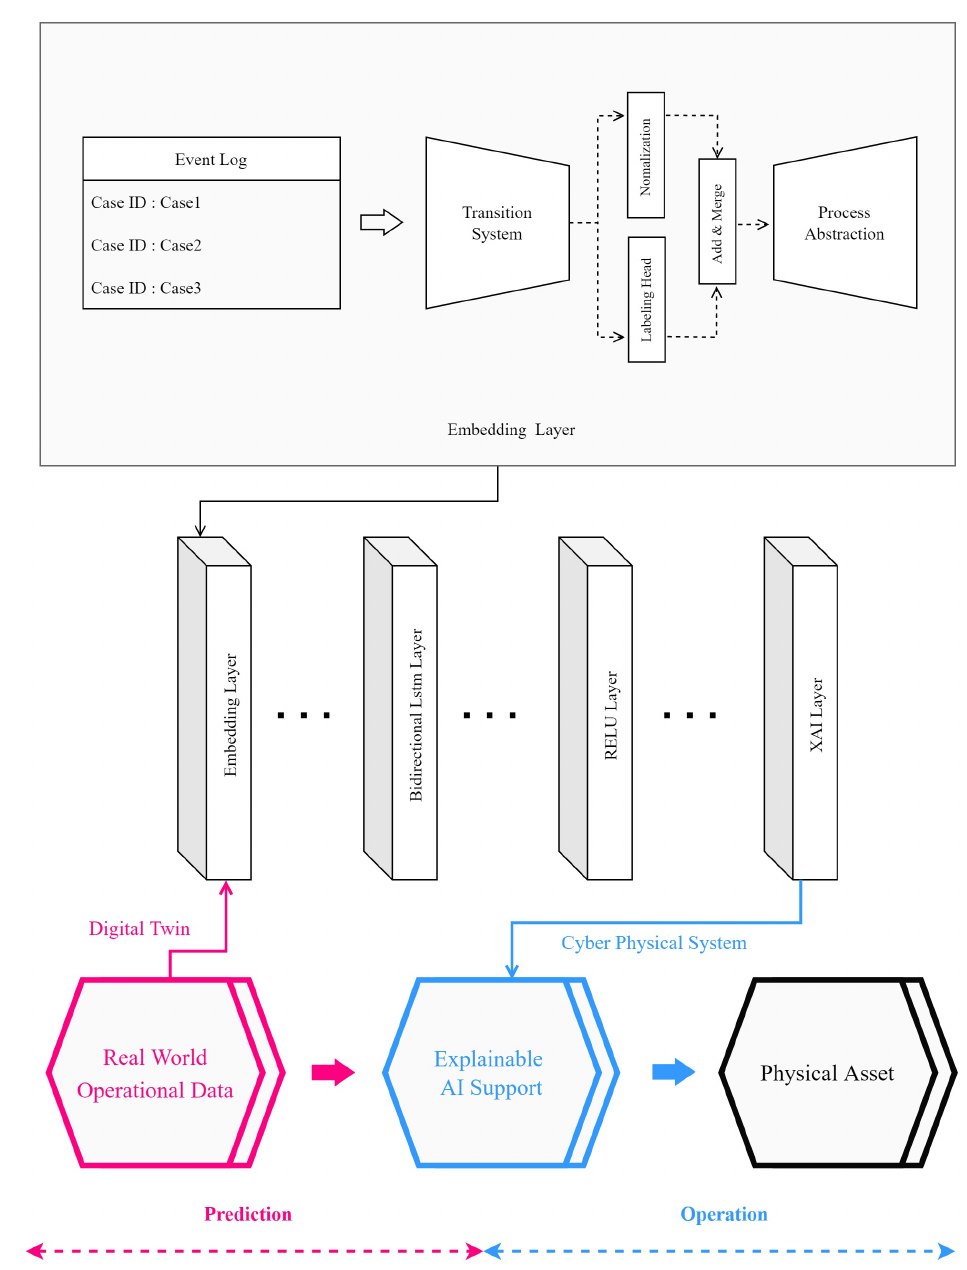
Figure 8. Smart factory manufacturing cooperative AI-workers